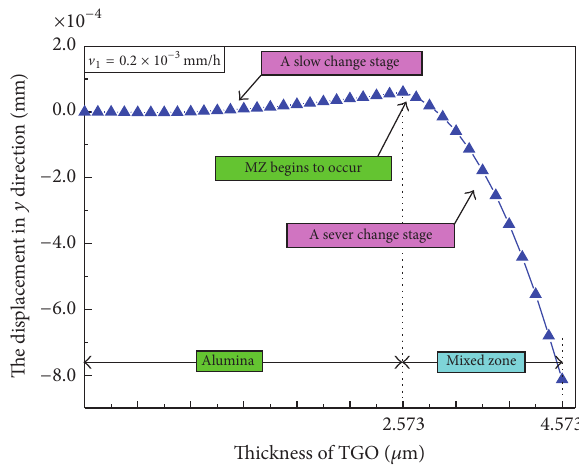
Figure 12: The plot of displacement in 𝑦 direction for node number 517 at the base of the surface groove against the number of thermal